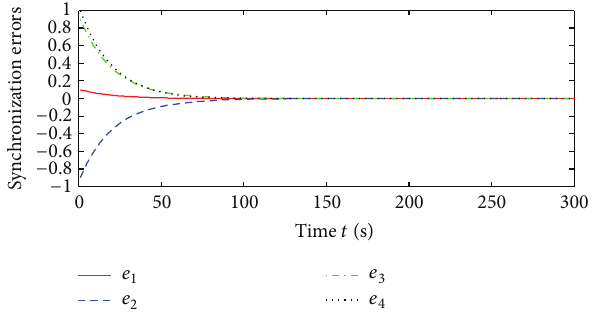
Figure 2: Synchronization between integer-order Chen system and fractional-order R¨ossler